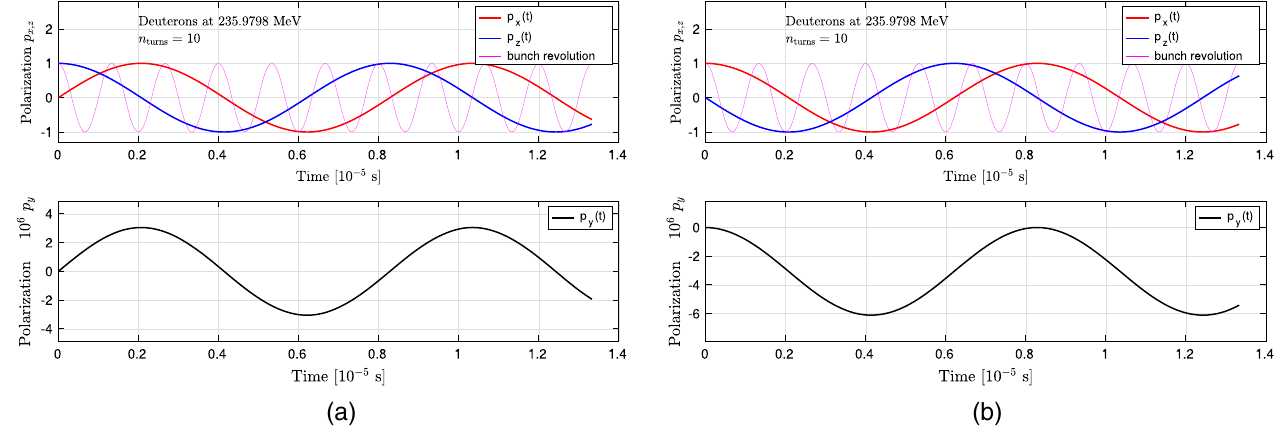
FIG. 2. Polarization evolution during idle precession for ten turns in an ideal ring using Eq. (19) and the parameters listed in Table I. ð t Þ , p ð t Þ and p ð t Þ for an initially longitudinal polarization, and panel (b) the same for initial sideways polarization. Panel (a) shows p x z y The bunch revolution is indicated as well. The magnitude of the p and Fig.